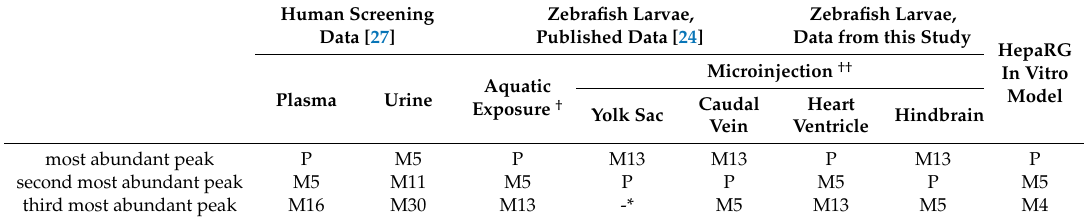
Table 2. Comparison of the major metabolites detected in the investigated models using LC- HRMS/MS.